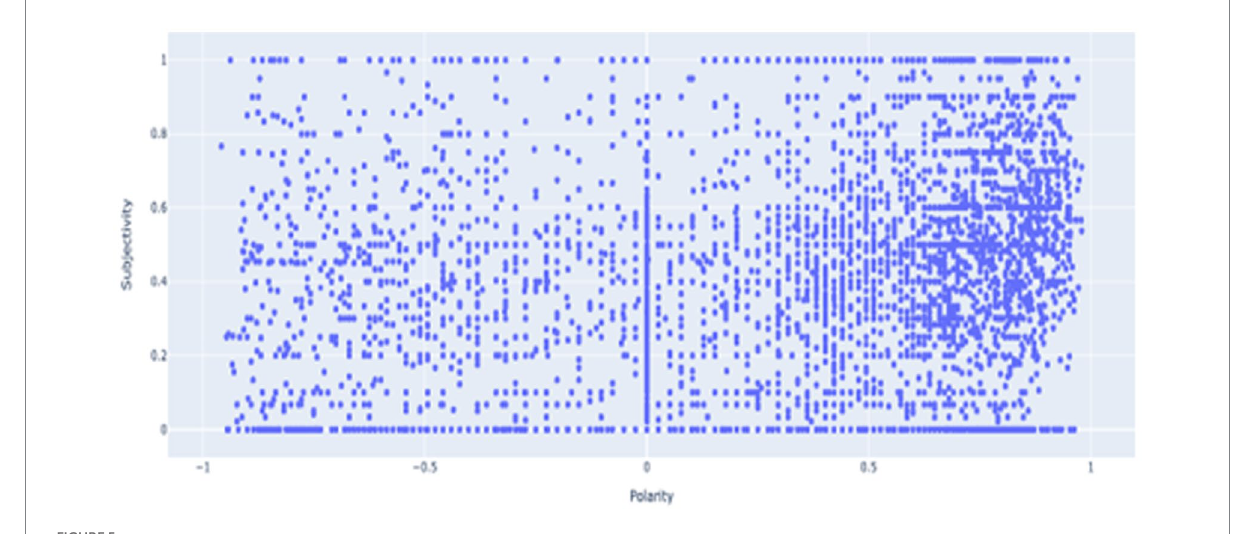
FIGURE 5 Subjectivity vs. polarity